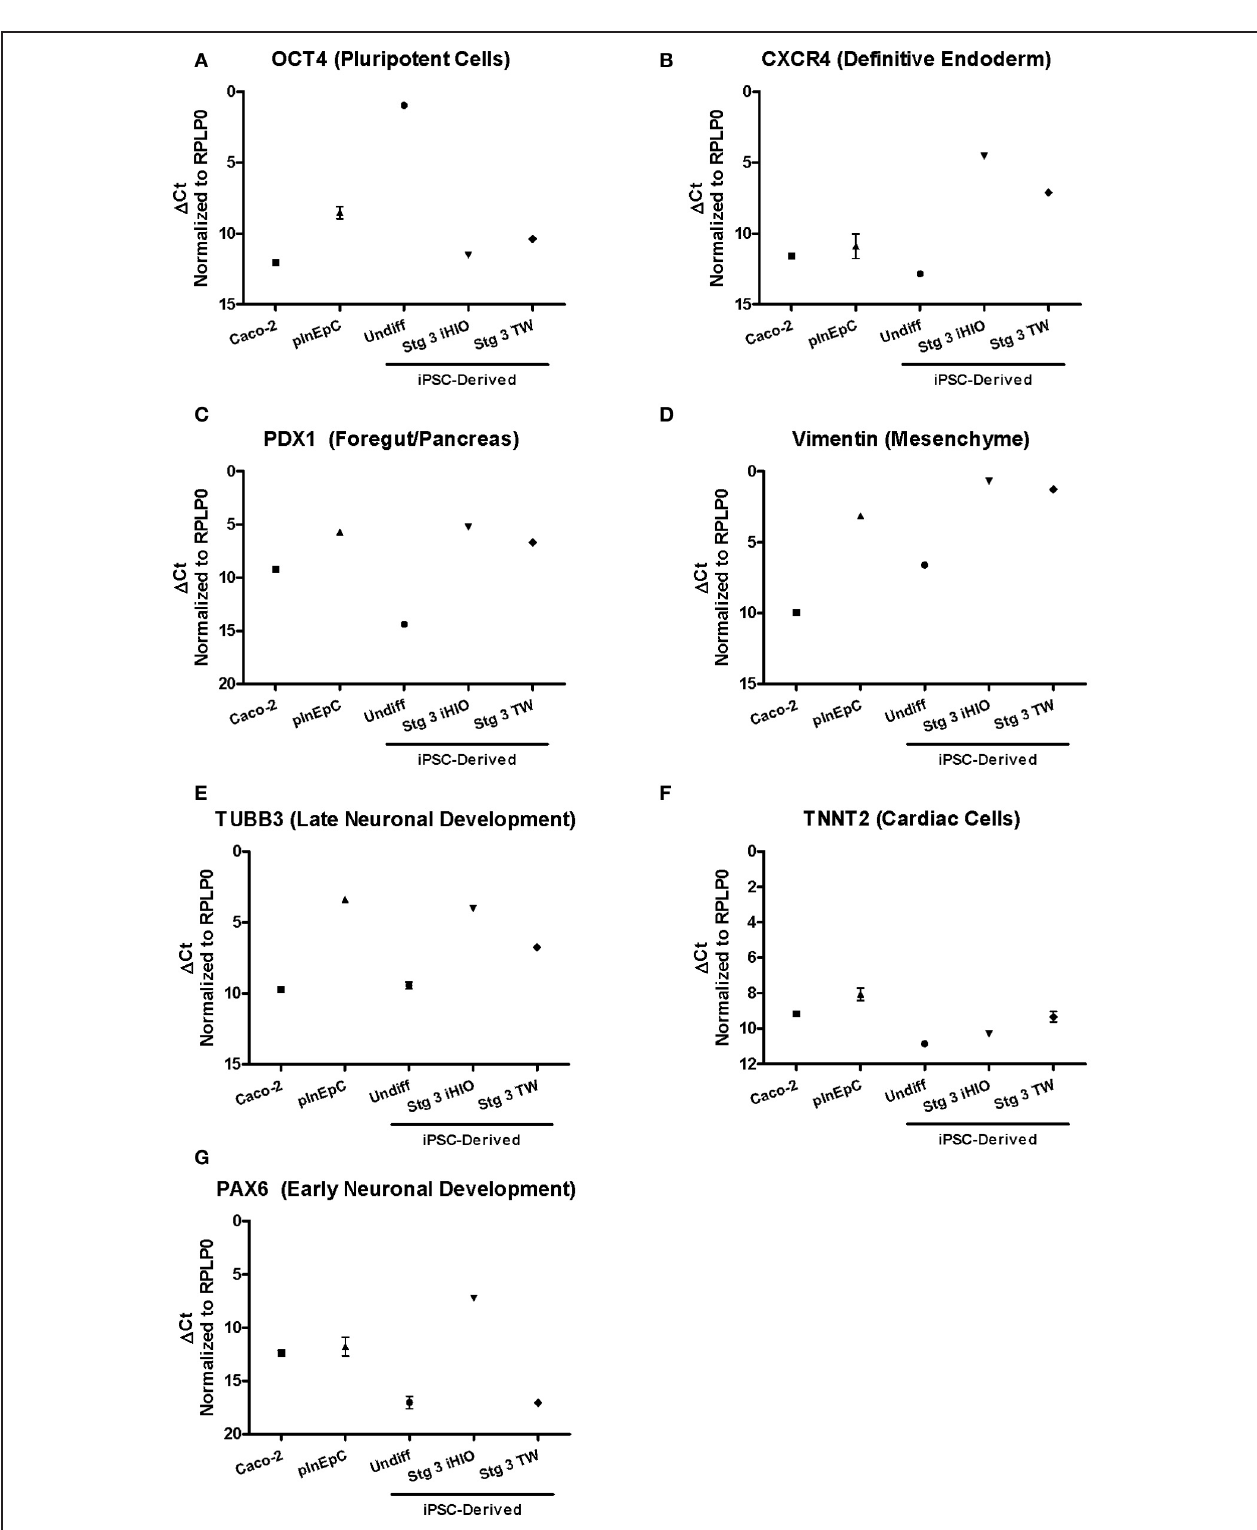
FIGURE A2 | Validation of intestinal cell RT-PCR analysis through a panel of control/non-intestinal markers. Expression of intestinal markers was evaluated by RT-PCR in Caco-2, primary hInEpCs (average of Donors A–C), and iPSC-derived undifferentiated (Undiff),